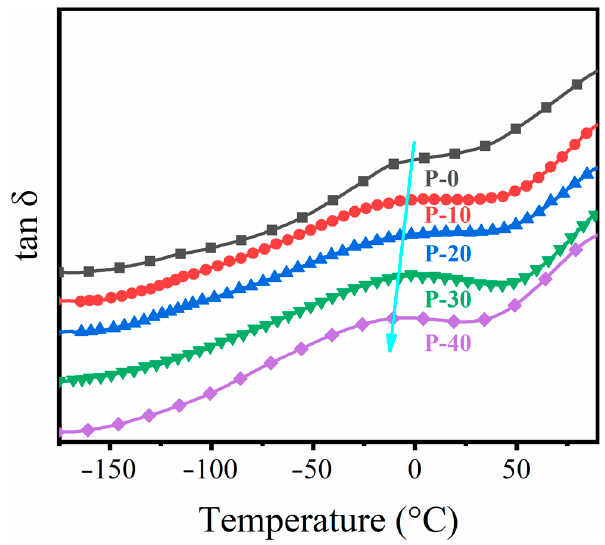
Figure 3. Temperature dependence of tan δ for PP and PP − g − PHMG/PP blended monofilaments, where arrows represented the trend of glass transition temperature.